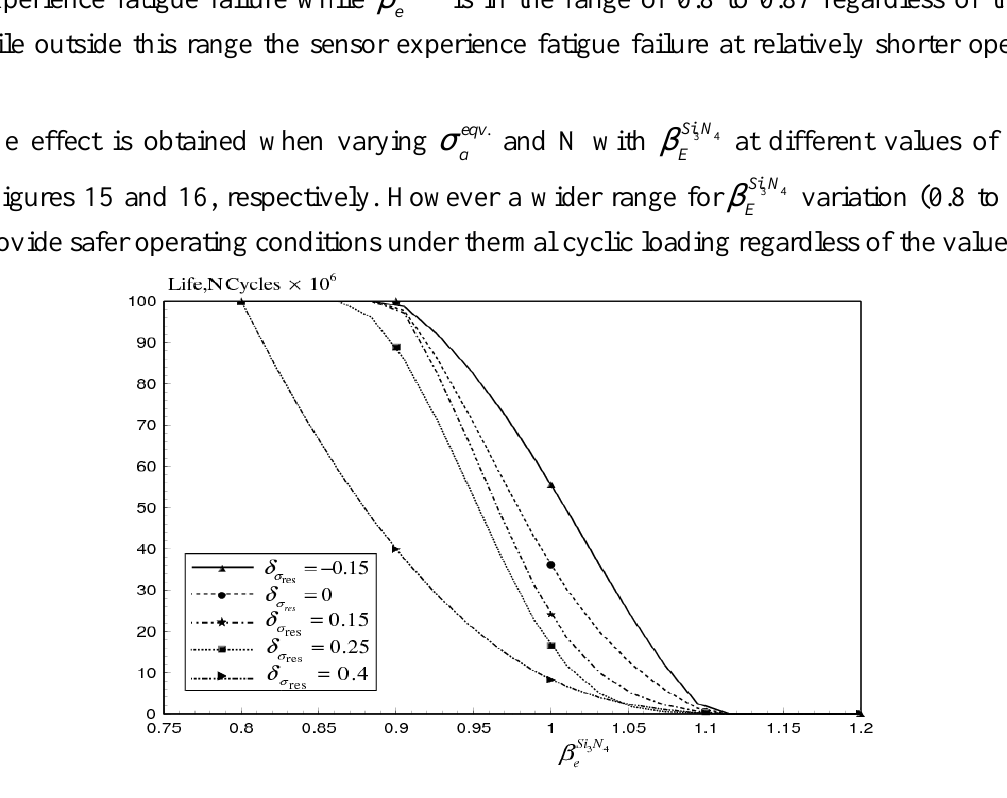
Si N on the equivalent alternating stress of Si 3 4